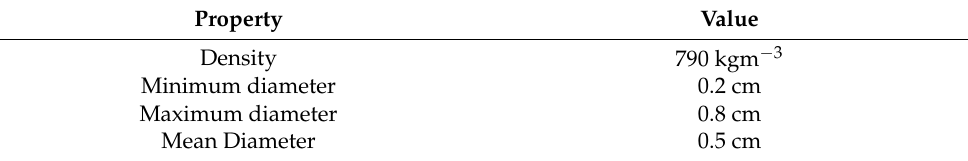
Table 3. Solid phase properties.